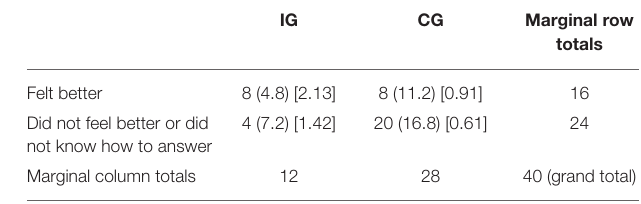
TABLE 9 | Incidental finding: participants in the intervention group felt better (mentally or physically) after adjusting their caffeine intake with set goals and reminders after 1 month ( p = 0.024).